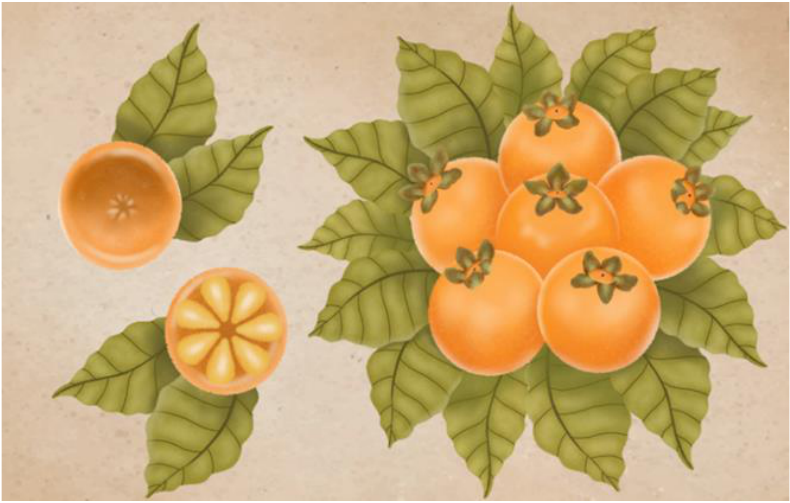
Figure 3. Gabiroba ( C. xanthocarpa ). Illustration made by the Ribeiro, L.V. (2022).